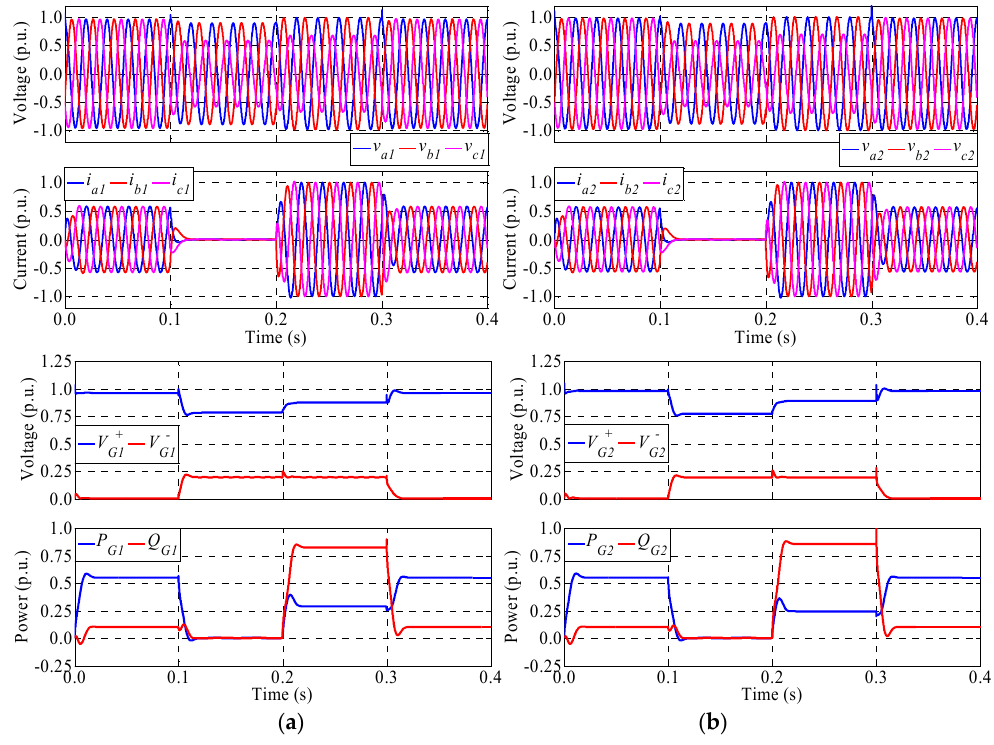
Figure 6. Main waveforms of ( a ) generator 1 and ( b ) generator 2 using the GCCS1 control scheme for type I voltage sag.